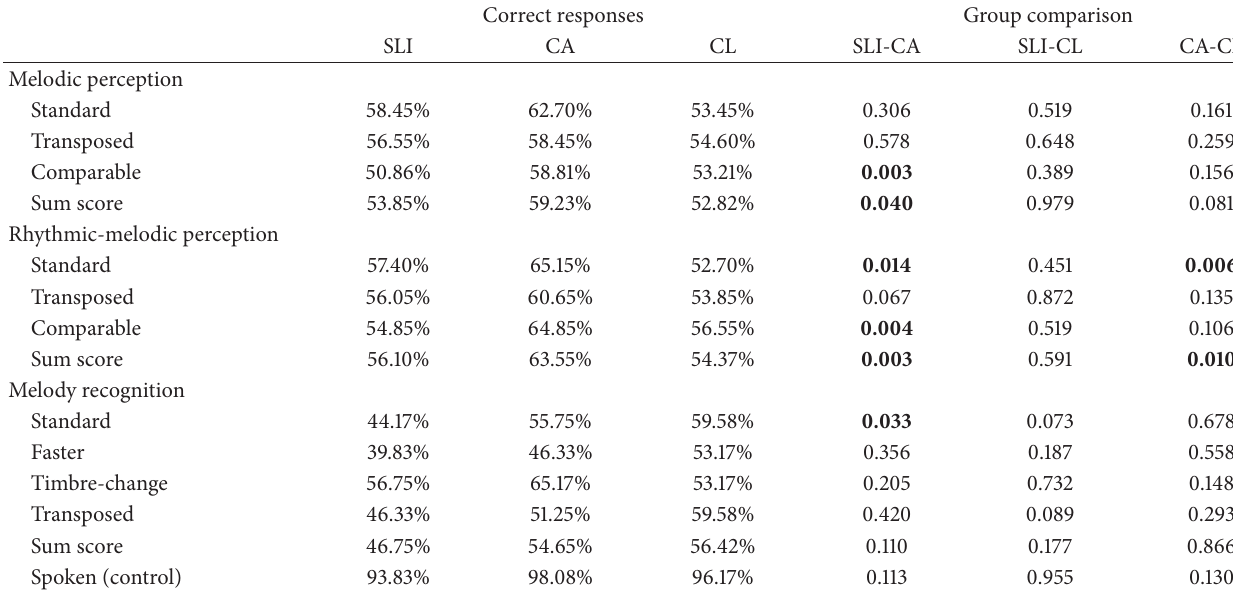
Table 2: The first three columns contain mean percentages of correct responses for children with Specific Langugage Impairment (SLI), children of comparable age (CA), and children with comparable linguistic abilities (CL). In the last three columns significance levels of the group comparisons (using the Mann-Whitney U tests) are given. Results for melodic perception are in the top section, rhythmic-melodic perception in the middle, and melody recognition at the bottom. Significant group differences are written bold.